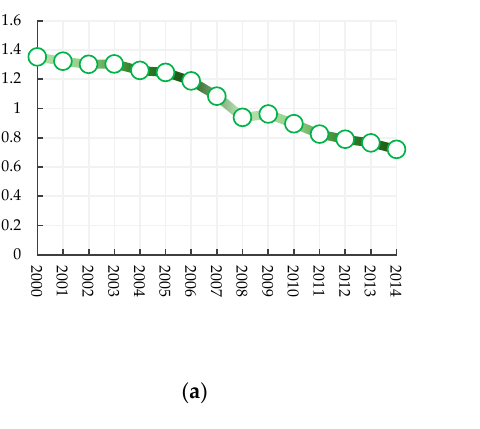
Figure 3. ( a ) Average carbon emission intensity of 17 manufacturing industries from 2000 to 2014; ( b ) Development of carbon emission intensity in 17 manufacturing industries from 2000 to 2014.